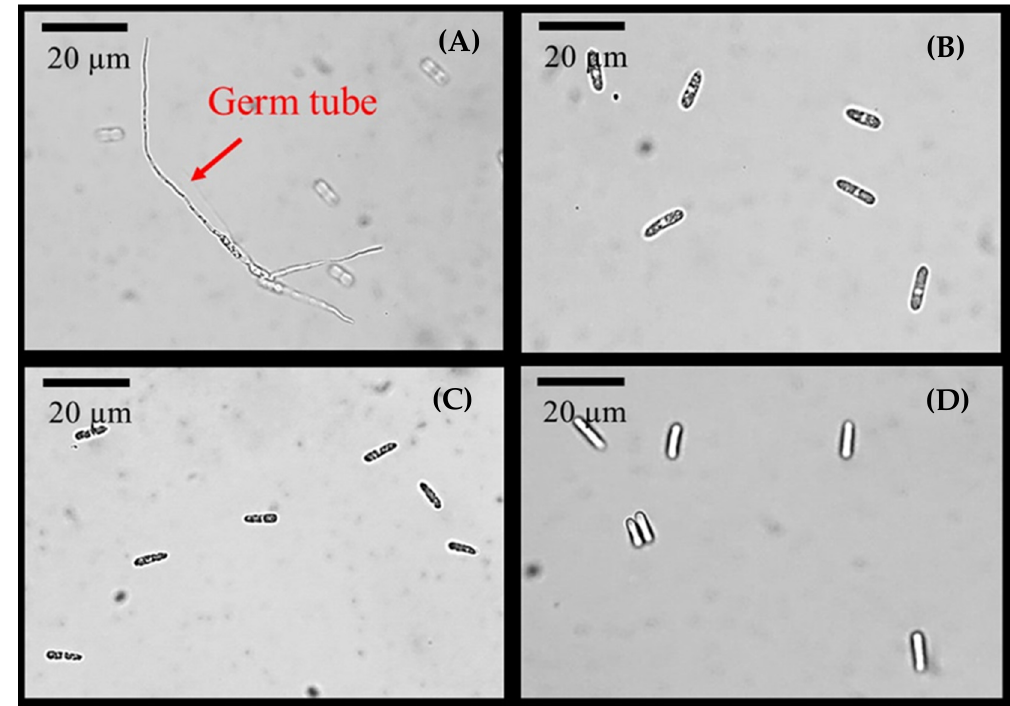
Figure 10. C. gloeosporioides spore germination after being treated for 48 h by ( A ) DI water, ( B ) PAW, ( C ) 10% NaClO, and ( D ) 70% ethanol.